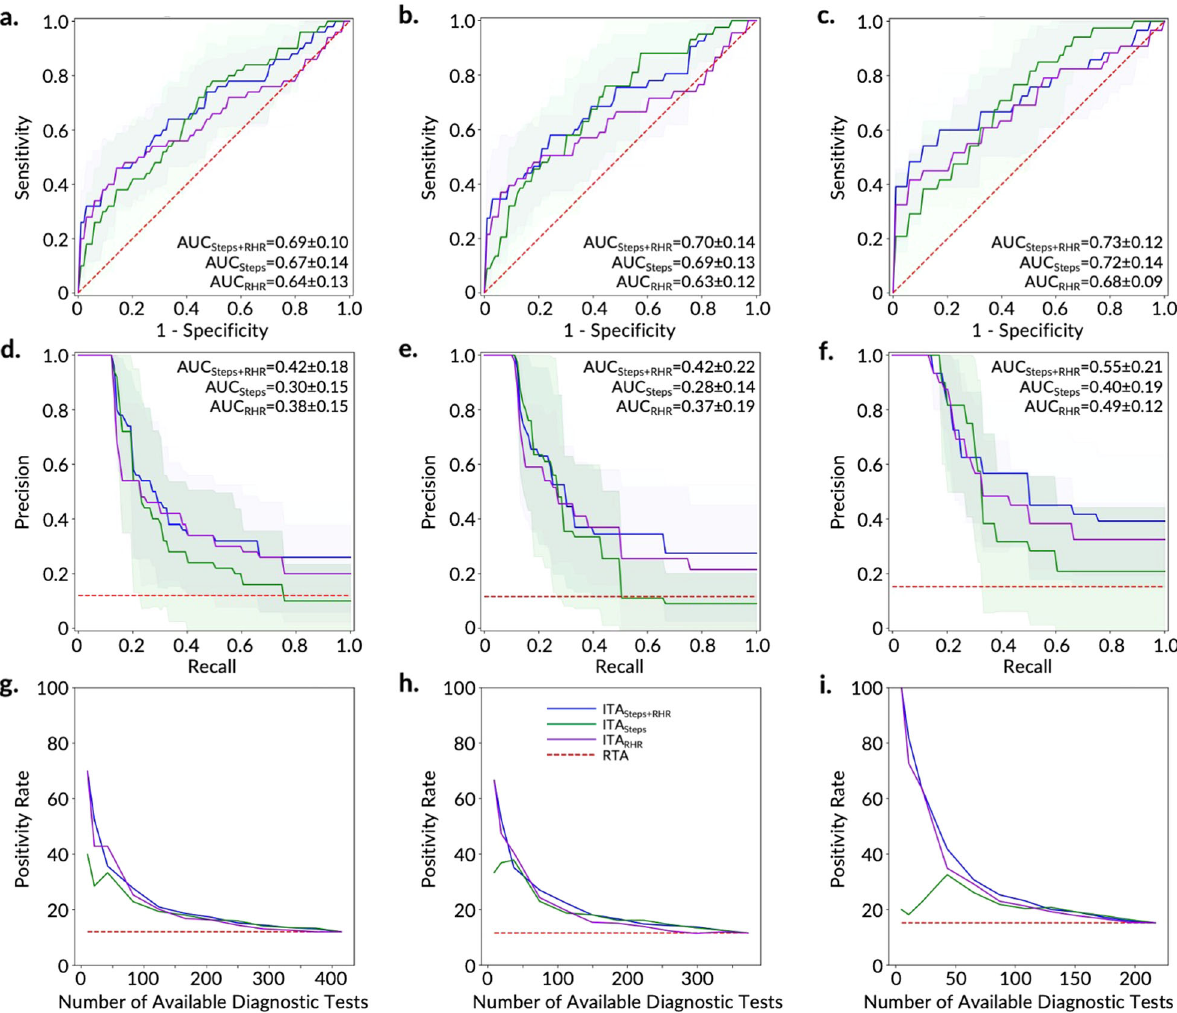
Fig. 3 Prediction and ranking results of the ITA models on the training sets for the AF (a, d, and g), AHF (b, e, and h), and FHF (c, f, and i) cohorts using features from a combination of Steps and RHR (blue), Steps (green), and RHR (violet) digital biomarkers. a – c Receiver operating characteristics curves (ROCs) and d – f precision-recall curves (PRCs) for the discrimination between COVID-19-positive participants and -negative participants in the training set. The light blue, light green, and light violet areas show one standard deviation from the mean of the ROCs/PRCs generated from 10-fold nested cross-validation on the training set and the red dashed line shows the results based on a Random Testing Allocation (RTA) model (the null model). g – i The positivity rate of the diagnostic testing subpopulation as determined by ITA given a speci fi c number of available diagnostic tests. The red dashed line displays the positivity rate/pretest probability of an RTA (null)